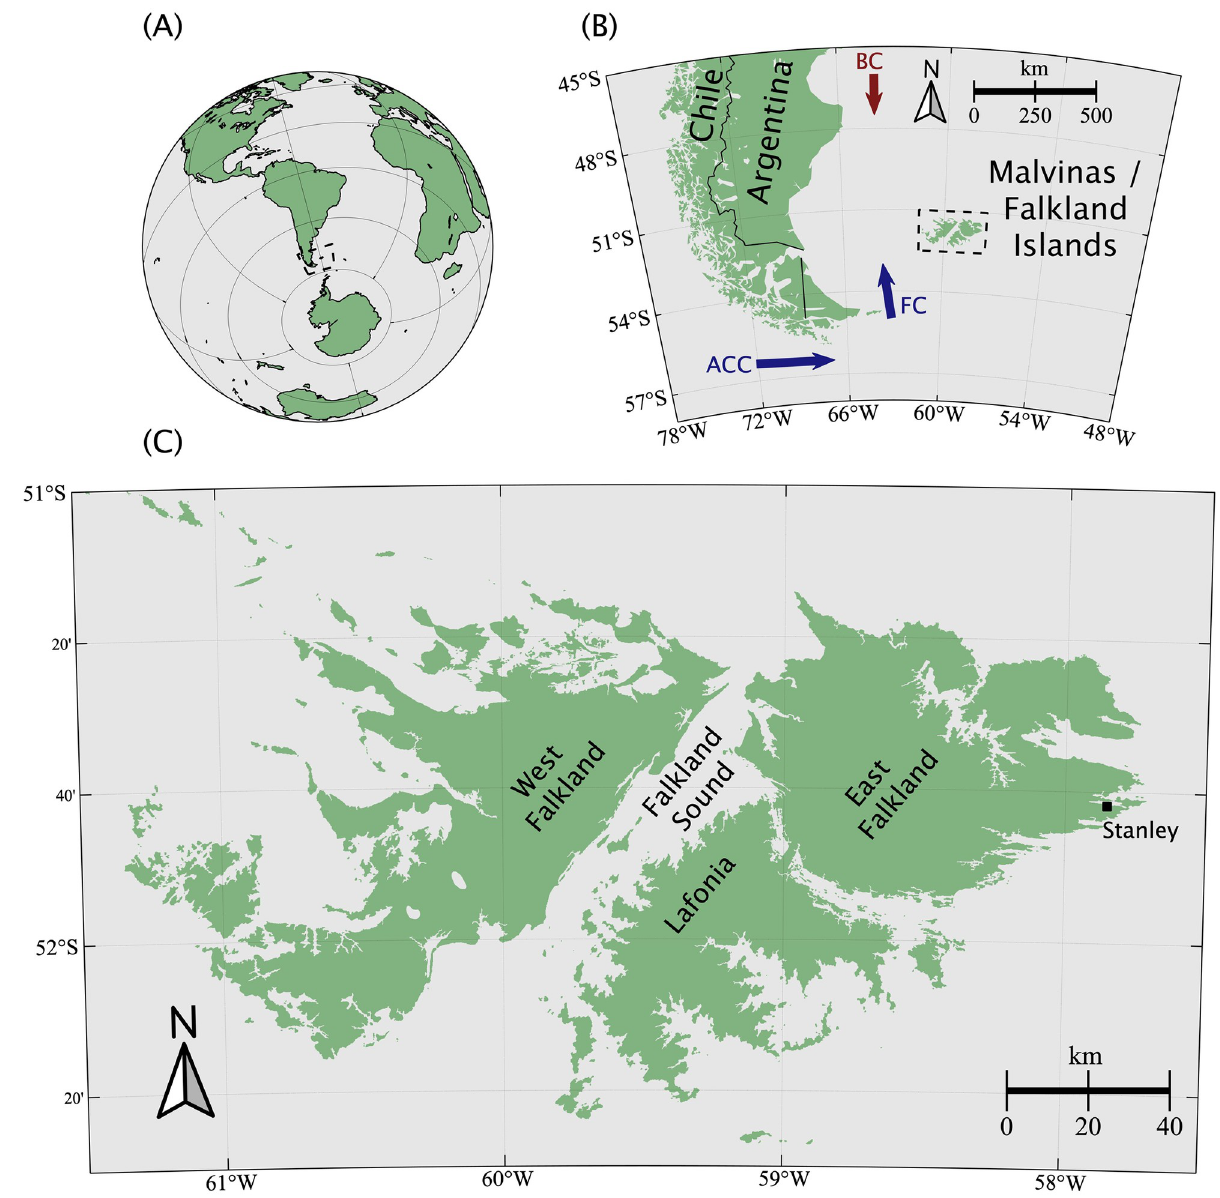
Fig 1. Map of Malvinas or Falkland Islands. The location and coastline of the Falkland Islands (Islas Malvinas) are shown at increasing scale within panels (A), (B), and (C). Within panel (B), the generalized location and direction of the Antarctic Circumpolar Current (ACC) and the Falkland Current (FC) are indicated in blue, and the Brazil Current (BC) is indicated in